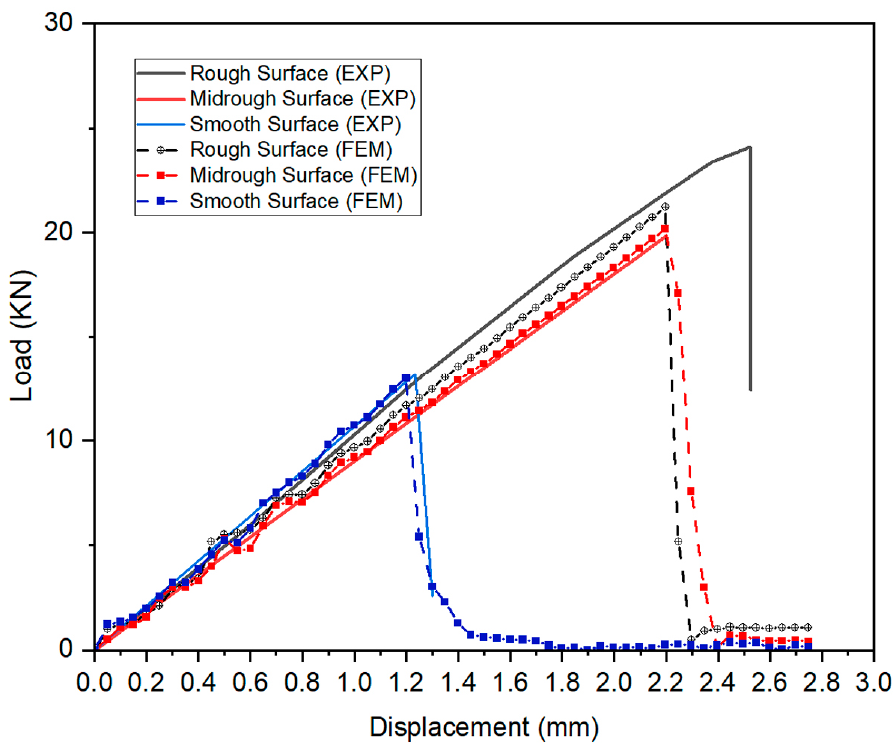
Figure 12. Comparison of the load-displacement characteristics between the EXP [21] and FEM for three distinct surface types in the tensile test.